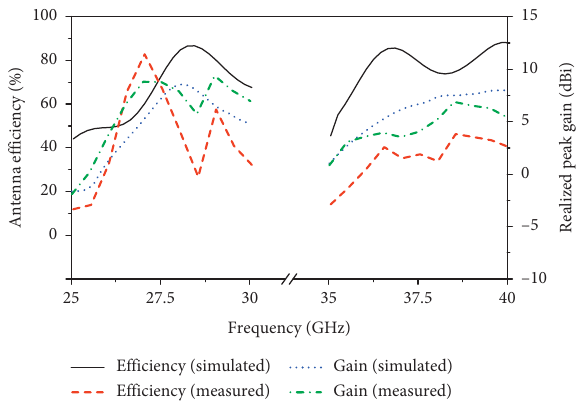
Figure 6: Antenna efciency and realized peak gain of the proposed unit element.